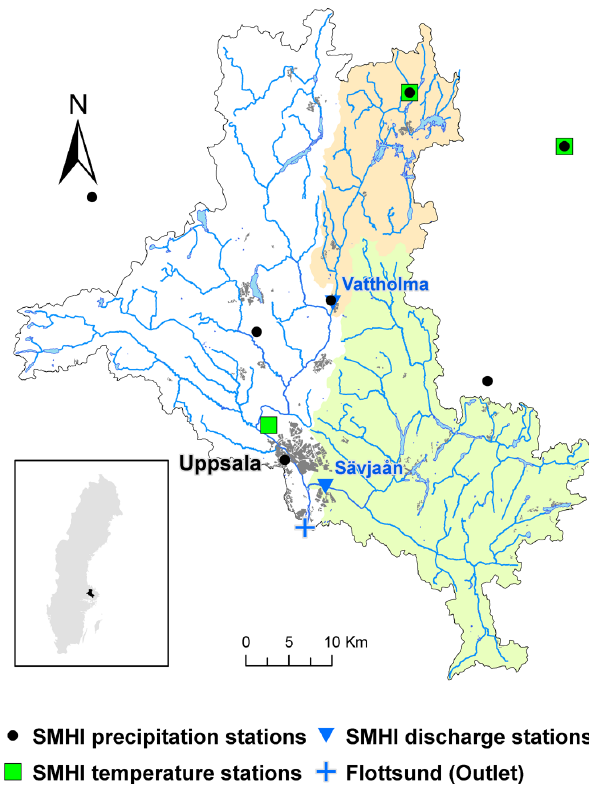
Fig. 1. The River Fyris